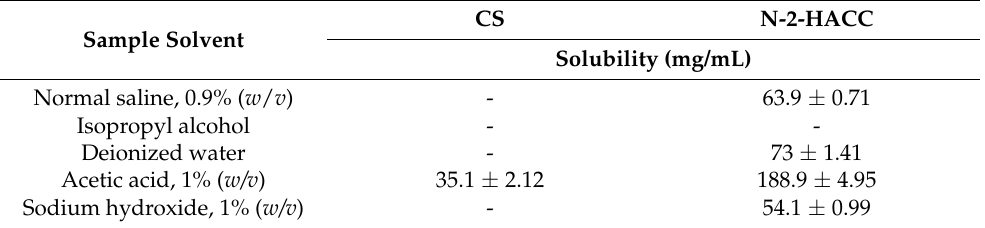
Table 4. Solubility of CS and N-2-HACC in different solvents at room temperature.